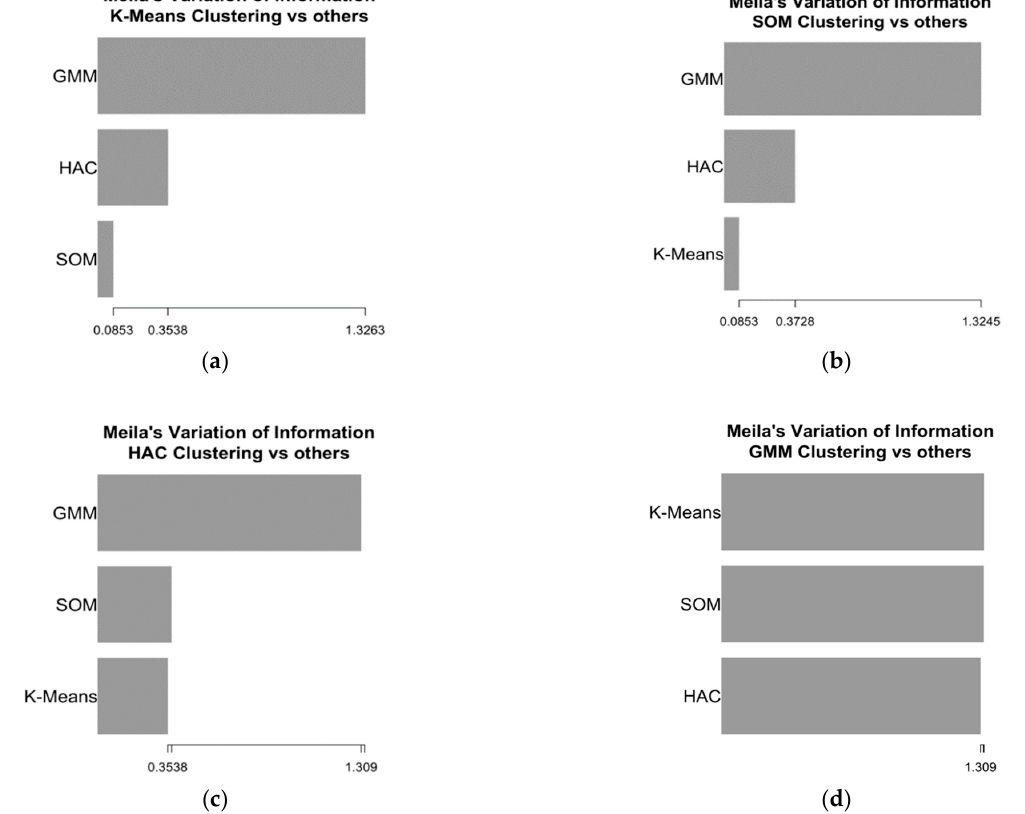
Figure 1. Meila’s variation of information (VI) of similarity for the two clusters obtained with four algorithms. ( a ) Meila’s VI for K-means; ( b ) Meila’s VI for SOM; ( c ) Meila’s VI for HAC; ( d ) Meila’s VI for the GMM.